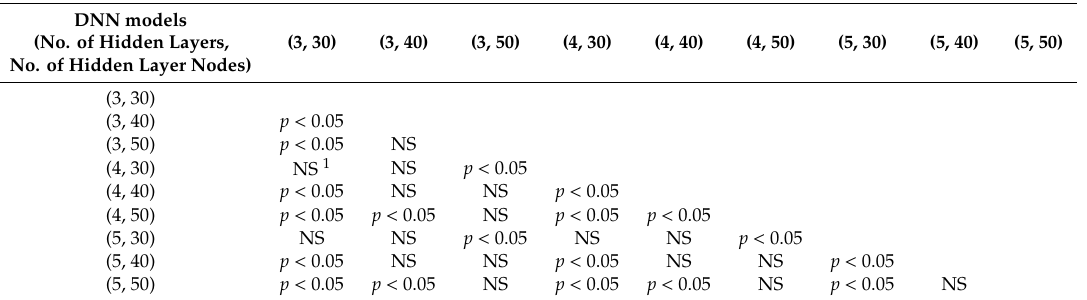
Table 9. Results of t-significance test for DNN models for predicting afternoon ore production with di ff erent hidden layer configurations.